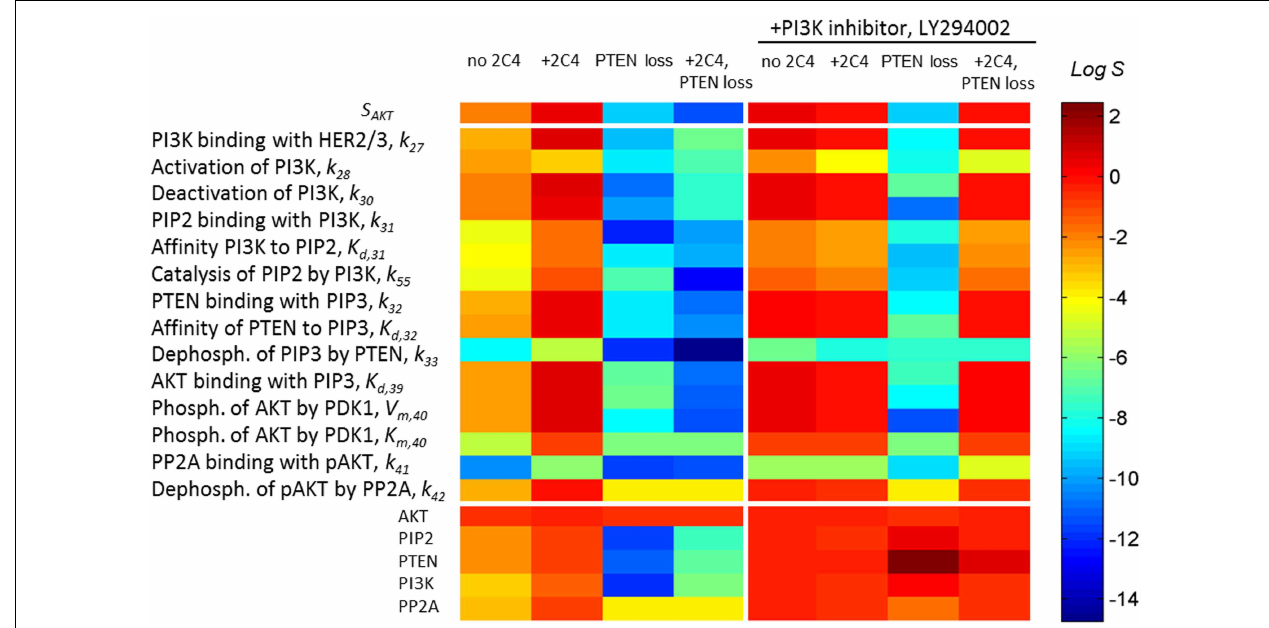
and at 50% PTEN loss in the absence (column 3) and presence of 100nM 2C4 (column 4). Columns 5–8 show S ATP,p as per columns 1–4 in the presence of 3 µ M LY294002.The relative change of the parameters in sensitivity analysis was 0.01% (see Eq. 4) and sensitivity values were taken at time t = 30min after HRG and 2C4